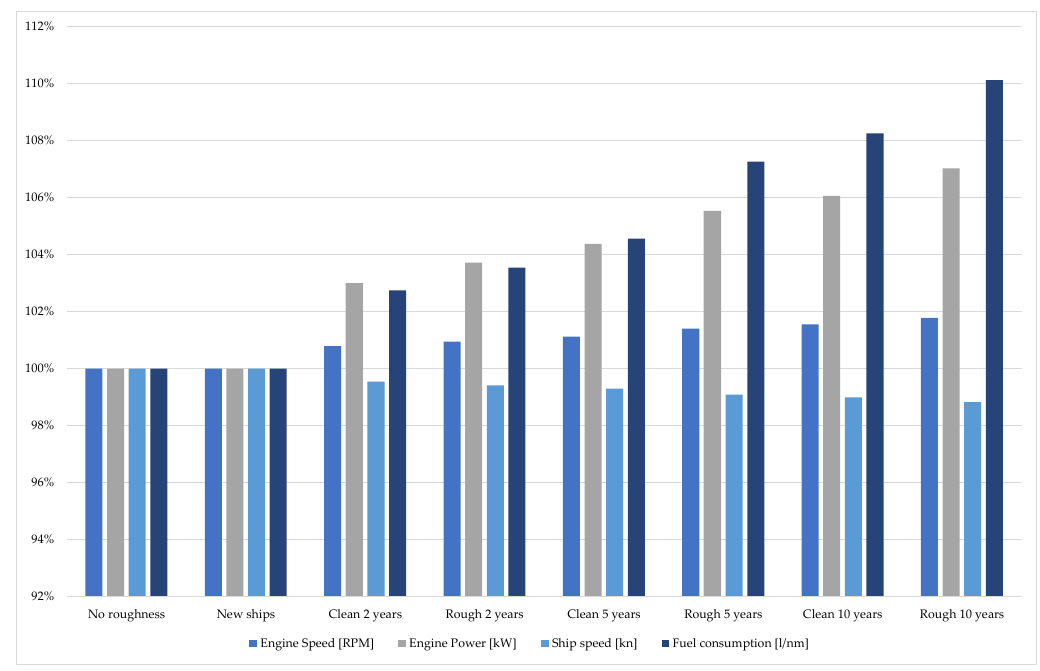
Figure 15. Effect of surface roughness on the performance of the ship along the route.